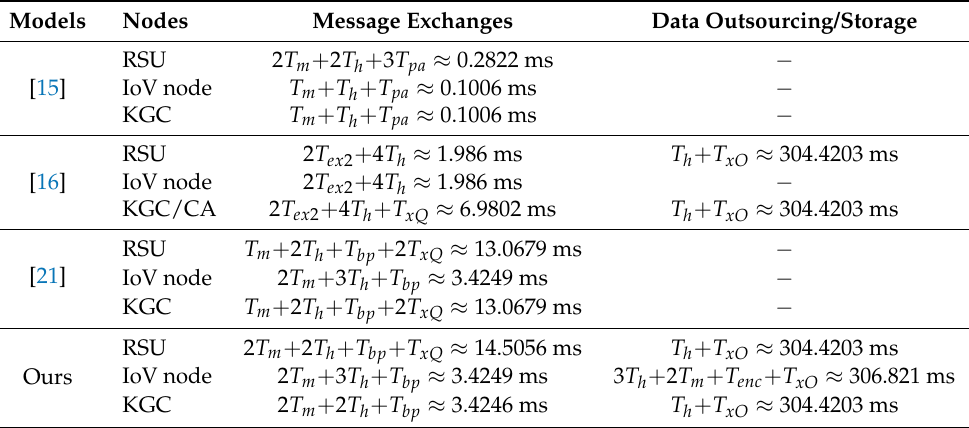
Table 3. Computational Cost Comparison.